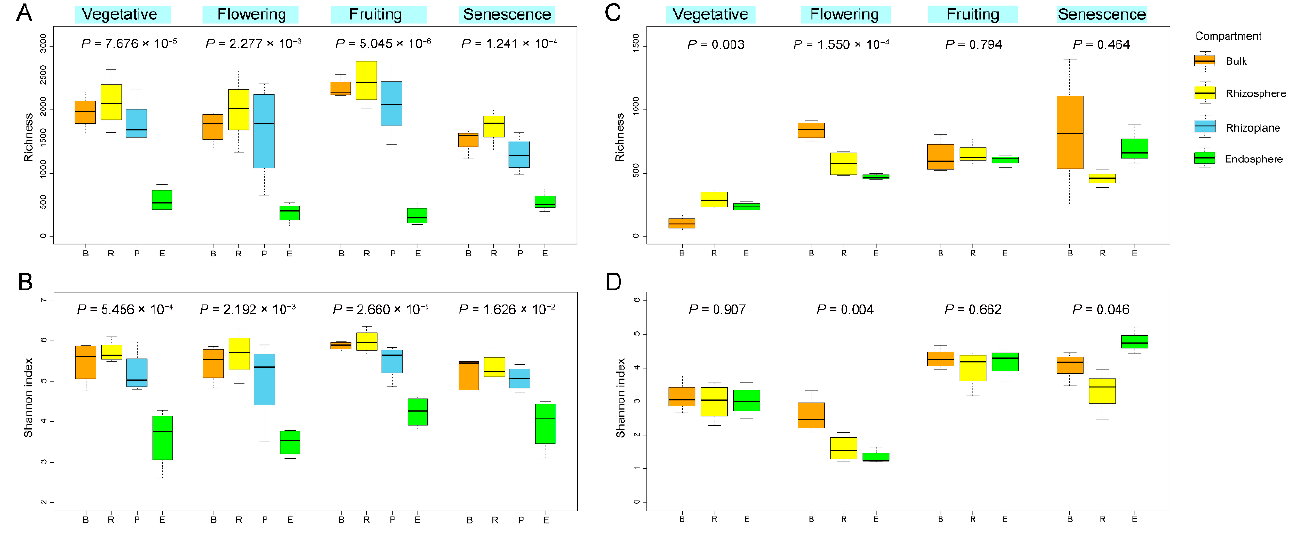
Figure 1. Estimated OTUs richness and Shannon diversity of rhizospheric compartments in each growth stage for bacterial ( A , B ) and fungal ( C , D ) communities, indicating a general decreasing gradient in the microbial diversity from the rhizosphere to the endosphere. The p values indicate significance between the four compartments.